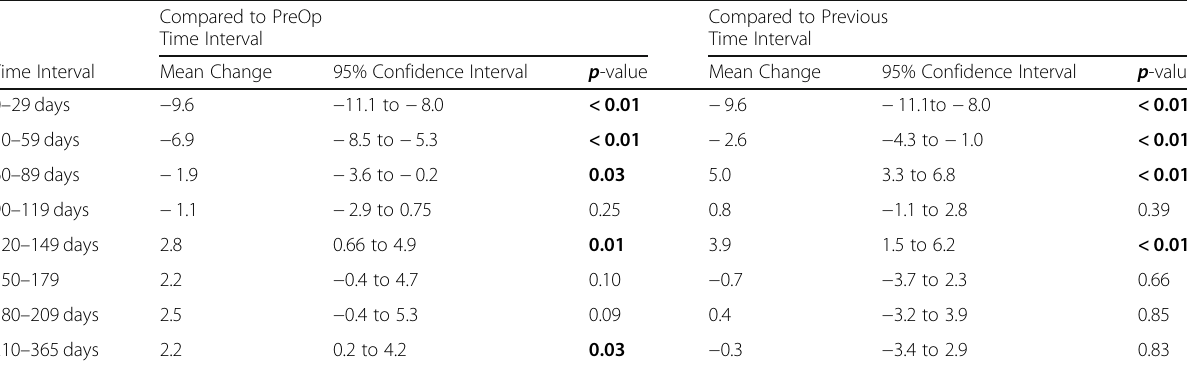
Compared to Previous Time Interval